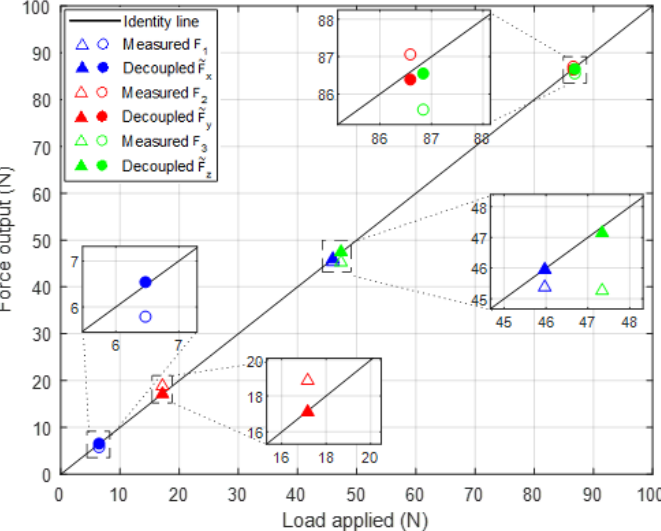
Figure 8. Decoupling method applied to necked collar links (Load case 1: Circles; Load case 2: Triangles).